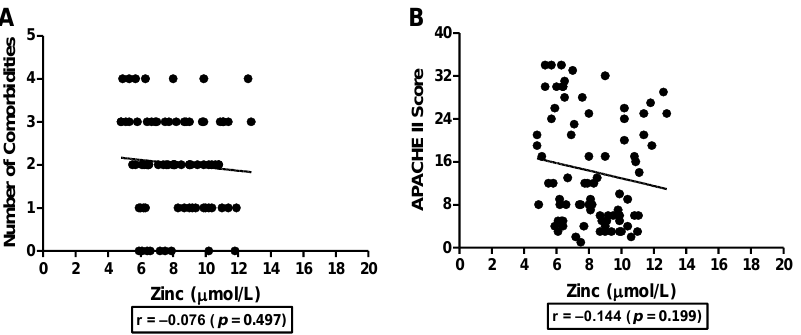
Figure 4. Association of number of comorbidities and APACHE II scores with serum zinc levels in hospitalized COVID-19 subjects. Number of comorbidities ( A ) and APACHE II score ( B ) were used to study the association with serum zinc levels in moderate and severe COVID-19 subjects admitted to either the hospital wards or ICU, respectively. Correlation was analyzed by Pearson correlation analysis.